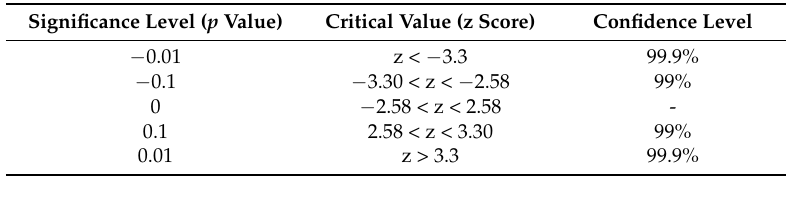
Table 1. Critical p -values and z-scores for different confidence levels.